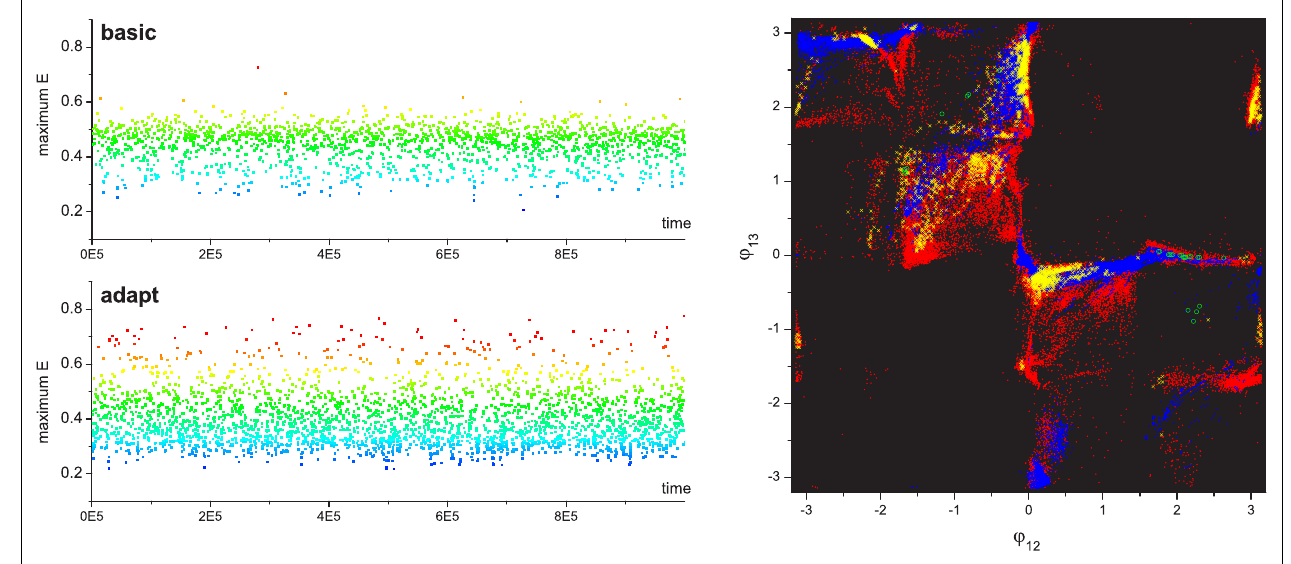
cyan circles (basic) and yellow crosses (adaptation). It can be seen that a large part of the high performing behaviors produced by reflex learning are located near the edge of areas of basic behaviors, indicating that a small difference in limb phase relationships made by adaptation can result in large performance differences, indicating a rugged fitness landscape.